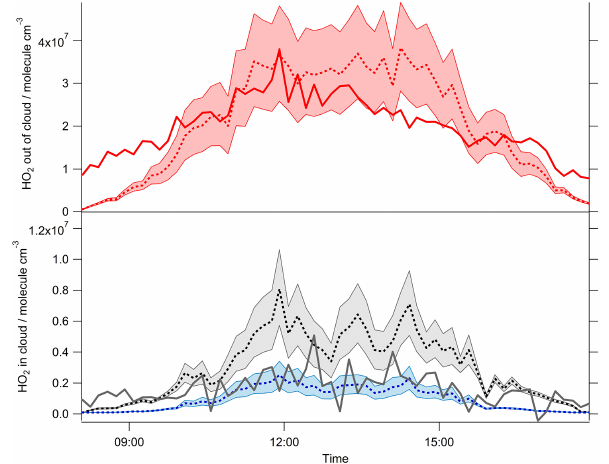
Figure 7. Lower panel. The dependence of the measured HO 2 con- centration (grey circles) and modelled HO 2 concentration with a variable first-order loss (red squares) as a function of cloud droplet surface area. Middle panel. The dependence of the first-order loss term used in the model expression to best replicate the observed in-cloud HO 2 as a function cloud droplet surface area, the line of best fit being ( k Loss = 2 ± 0.1 × 10 − 4 × SA). Upper panel. The de- pendence of γ HO calculated using Eq. (7) as a function of cloud 2 droplet surface area and constrained with the variable first-order loss term as shown in the middle panel. The line of best fit is ( γ HO =2.9 ± 0.5 × 10 − 5 × 2